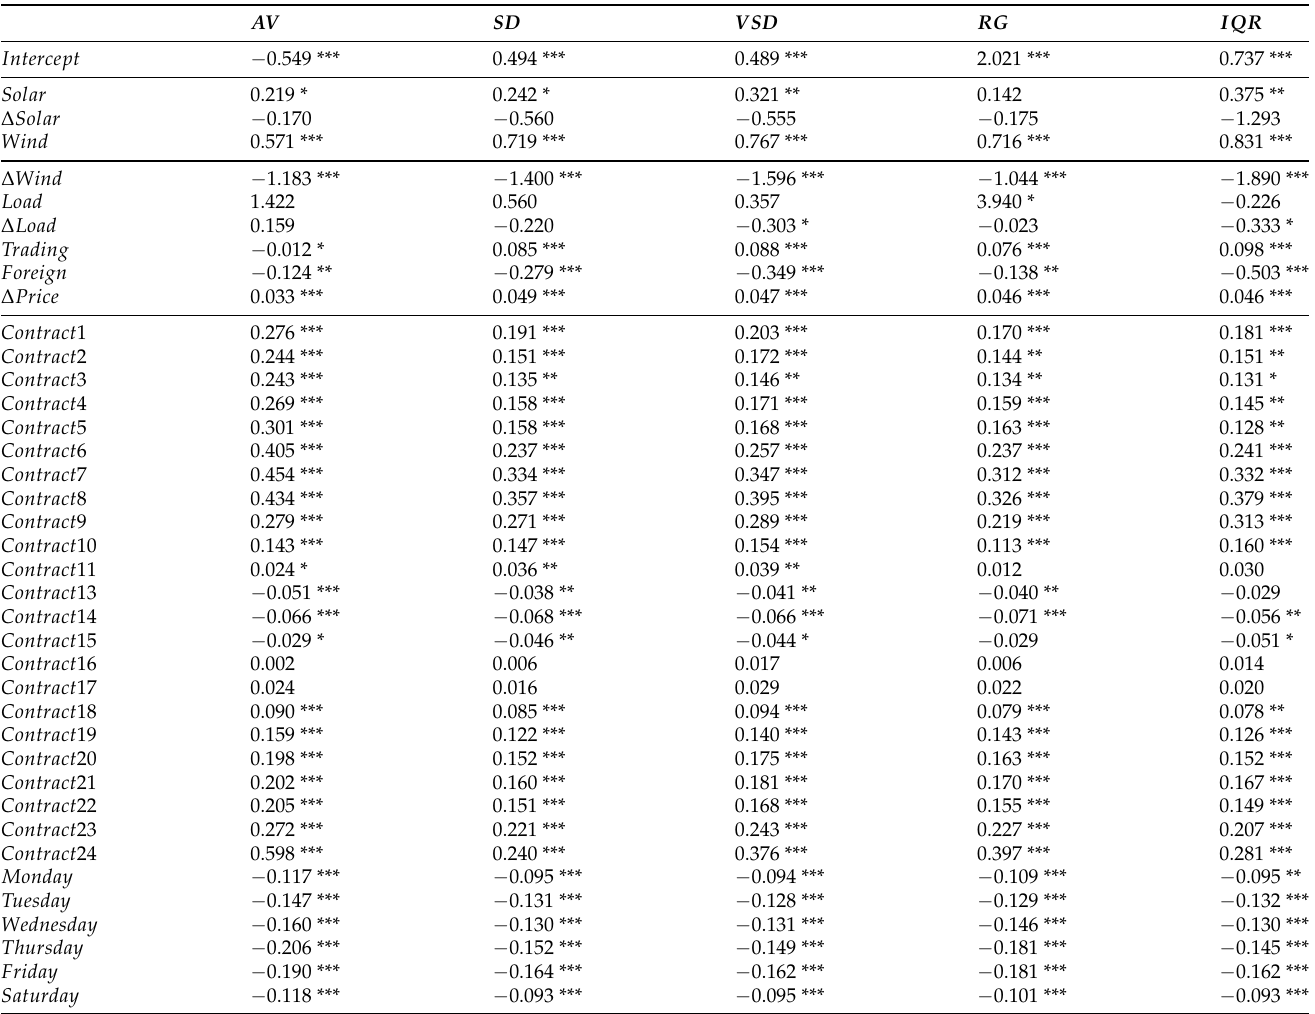
Table 3. Regression results for the five measures for the total price fluctuations. AV is the standard deviation of the price differences consecutive trades, SD is the standard deviation, VSD is the volume-weighted average standard deviation, RG is the range, and IQR is the interquartile range of all observable prices. Solar is the relative solar share of the total consumption, and ∆ Solar is the relative solar forecast error of the total consumption. Wind and ∆ Wind are analogously defined as the relative wind share and the relative wind forecast error of the total consumption. Load is the volume of the total consumption in TWh, ∆ Load is the unsigned relative excess generation over consumption in Germany, Trading is the traded volume of the intraday market in GWh, Foreign is the relative share of the volume (buy and sell) traded between Germany and a foreign country and the total traded volume of the intraday market, and ∆ Price is the absolute price difference of the day-ahead auction price and the volume-weighted average intraday price. The successive variables represent fixed effects for hour, day, season, year, summer time, and late trading within a control zone. RMSE is the root mean squared error, and MAE is the mean absolute error. The asterisks denote the significance level with *** = 0.1%, ** = 1%, and * =